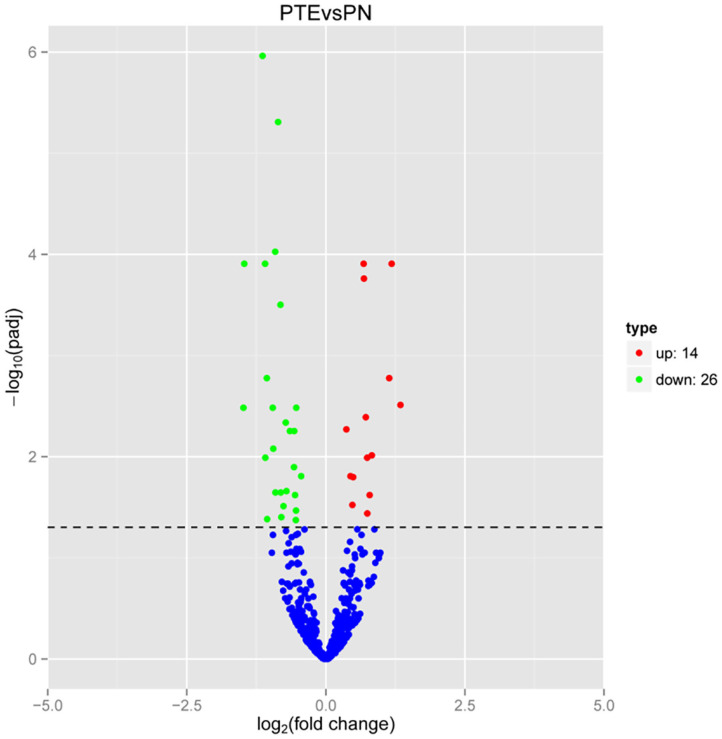
MicroRNA transcriptome analysis in rat frontal lobe by RNA-Seq. A volcano plot of RNA-seq microRNA transcriptome data displays miRNA expression values of PTE rats compared with those of sham rats. Significantly differentially expressed microRNAs (adjusted P-value < 0.05) are highlighted in red (upregulated) or green (downregulated). Non-differentially expressed microRNAs are highlighted in blue. n = 6.